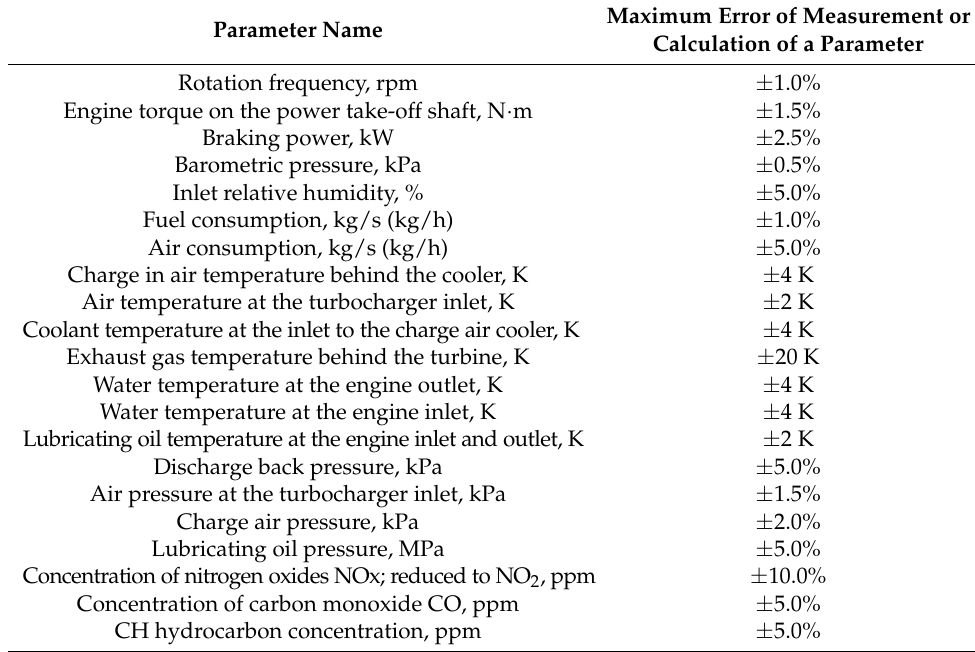
Table 2. The list of measured parameters and the error of